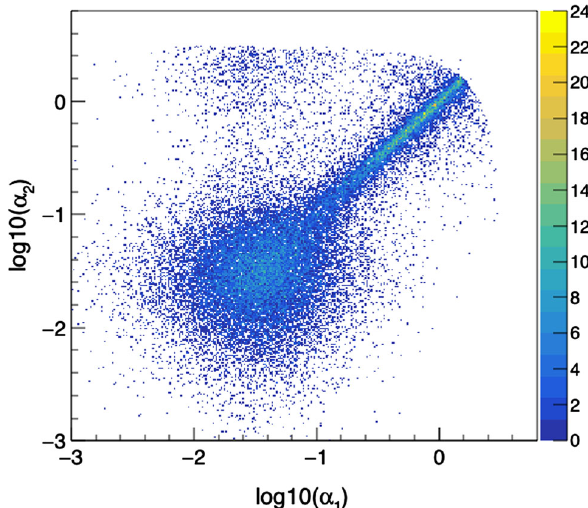
Fig. 15 The correlation of α 1 versus α 2 (unit in radians), the angu- lar difference between reconstructed di-jet systems and the MC truth bosons of the inclusive WW